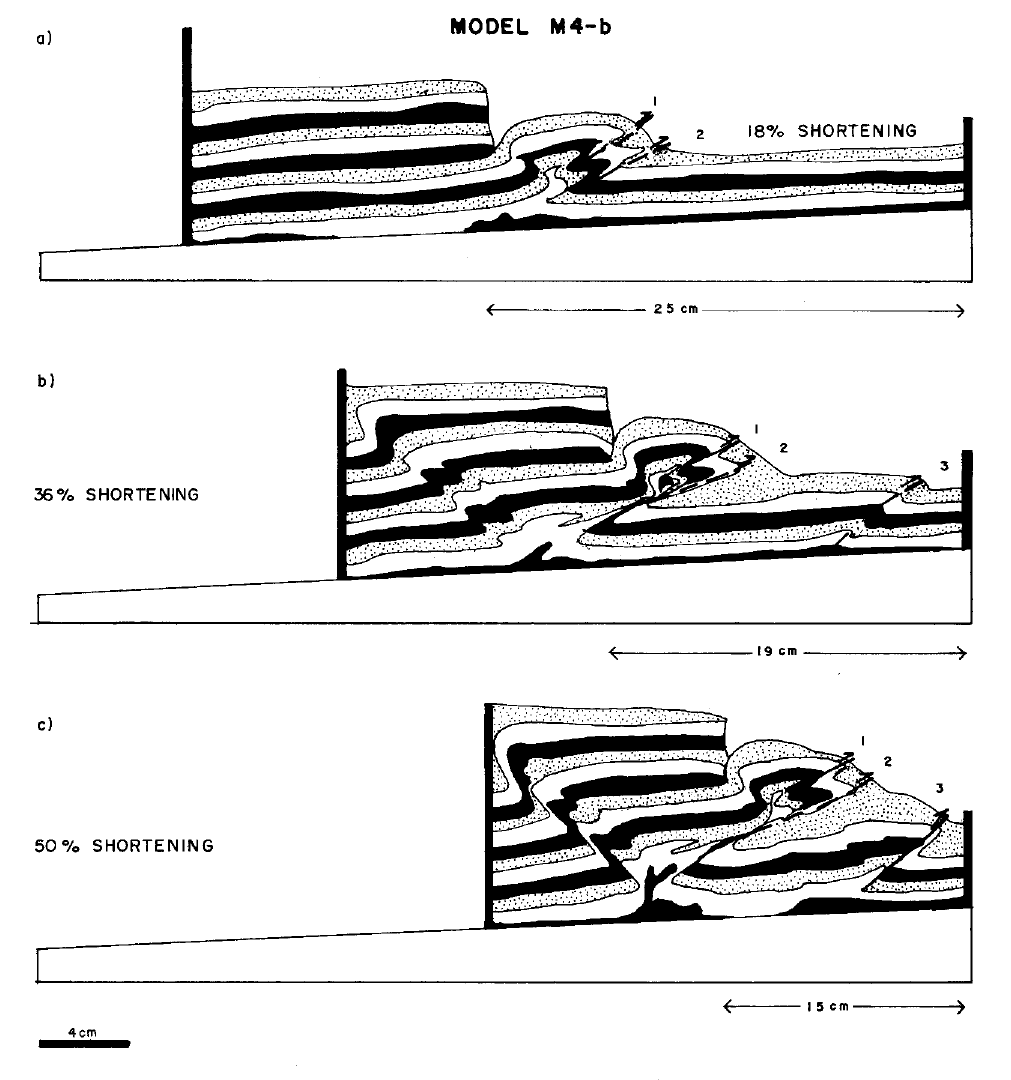
Fig. 13 – Model M4-b in three successive stages (the same boundary conditions as in model M2-b with additional 5 ◦ tilt towards the hinterland). After (a) 18%; (b) 36%; and 50% shortening. Deformation is the same as in model